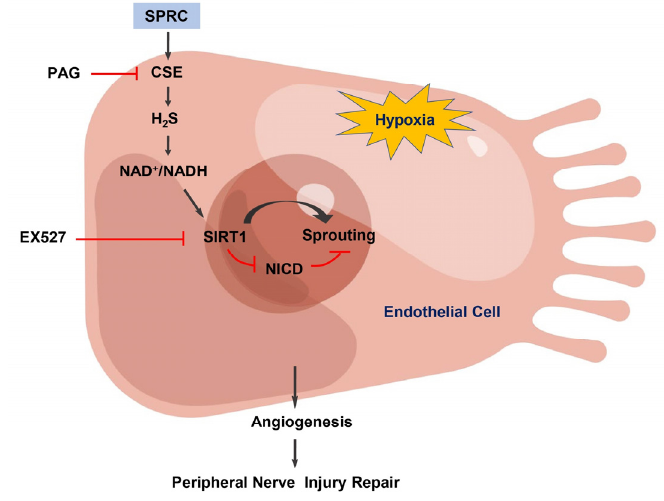
Figure 6. Schematic illustration of H 2 S/SIRT1/NICD-mediated mechanism in SPRC-induced angiogenesis under hypoxic condition. SPRC increases the expression of CSE to produce endogenous H 2 S, and H 2 S may activate SIRT1 by increasing the NAD + /NADH ratio. Under hypoxia, SIRT1 deacetylated NICD and relieved the inhibitory effect of Notch signaling pathway on angiogenesis.